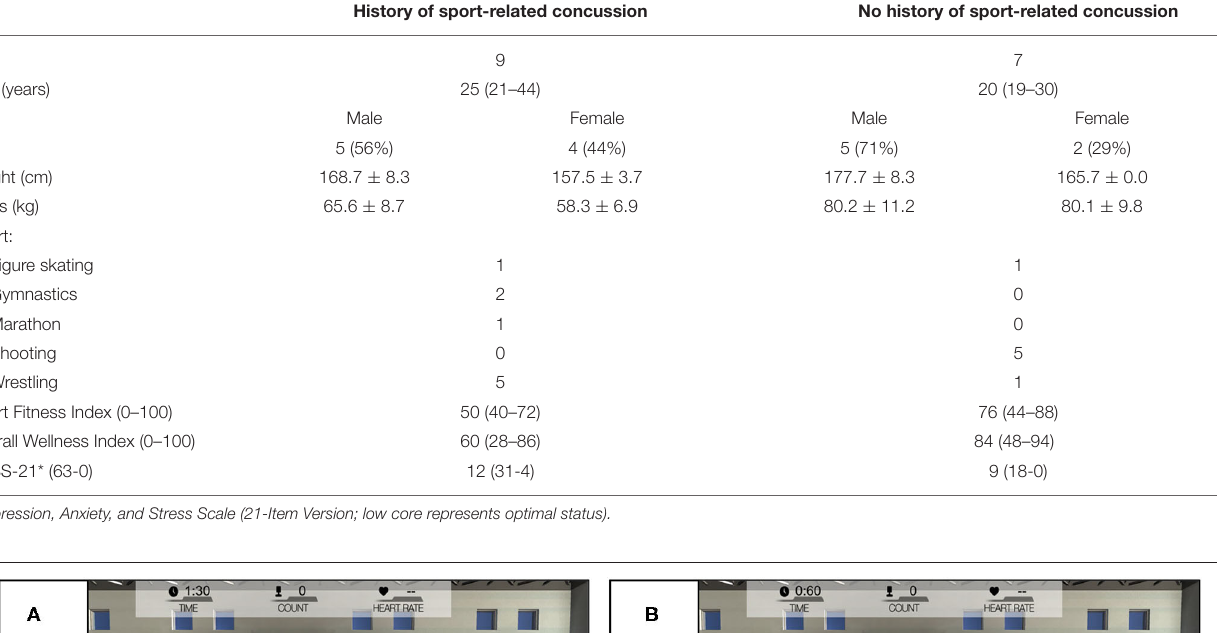
with the goal to quickly deactivate a virtual target on the monitor by moving the body core to a corresponding 2-dimensional X- Y spatial coordinate within the performance space ( Figure 1 ). Immediately after virtual target deactivation, the athlete reversed the movement direction to rapidly return to the original central position for the start of another trial. A single-task ( ST ) mode